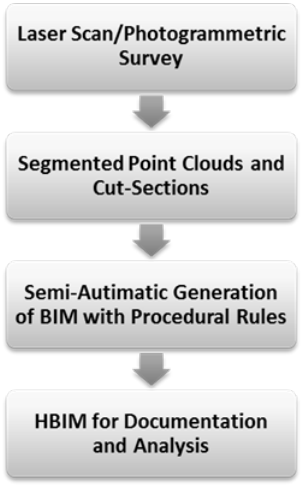
Figure 3: Procedural